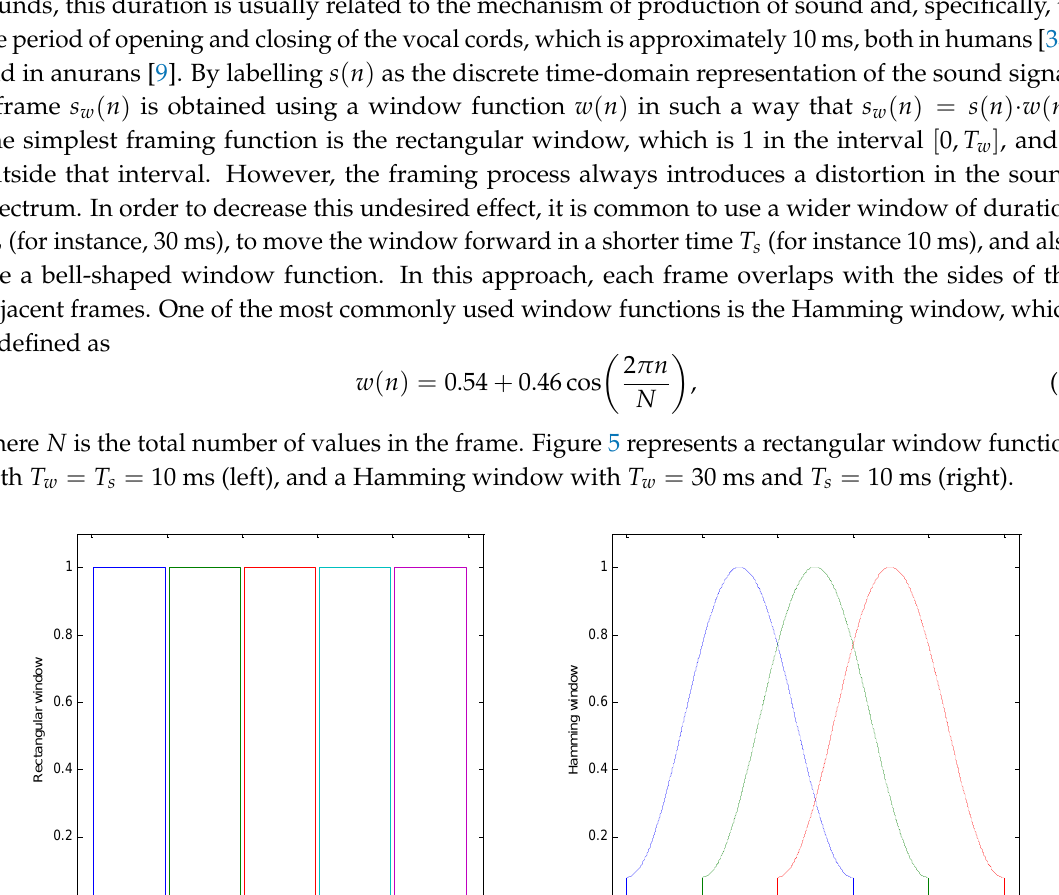
Table 1. Dataset of sounds and patterns.